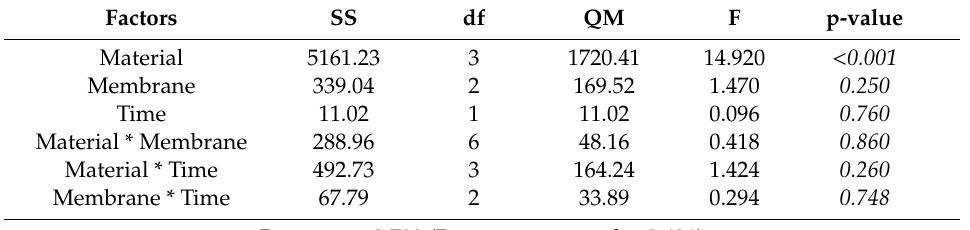
Table 2. Multifactorial ANOVA: Factors; Sum of squares (SS); Degrees of freedom (df); Quadratic mean (QM); Fisher’s statistical (F) and statistical significance (p-value). Significant value p < 0.05*.